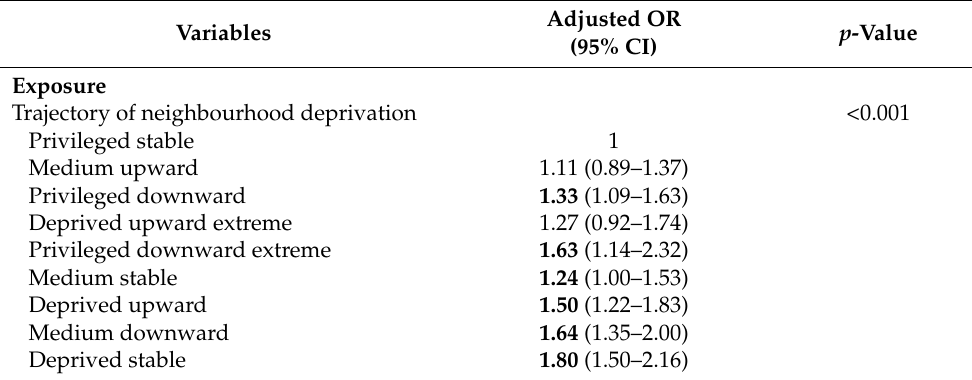
Table 3. Associations between long-term NDT and poor self-perceived health.